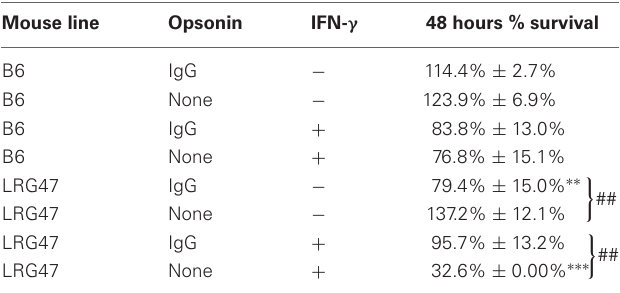
Table 1 | Variable effect of opsonization on survival of Brucella in LRG-47